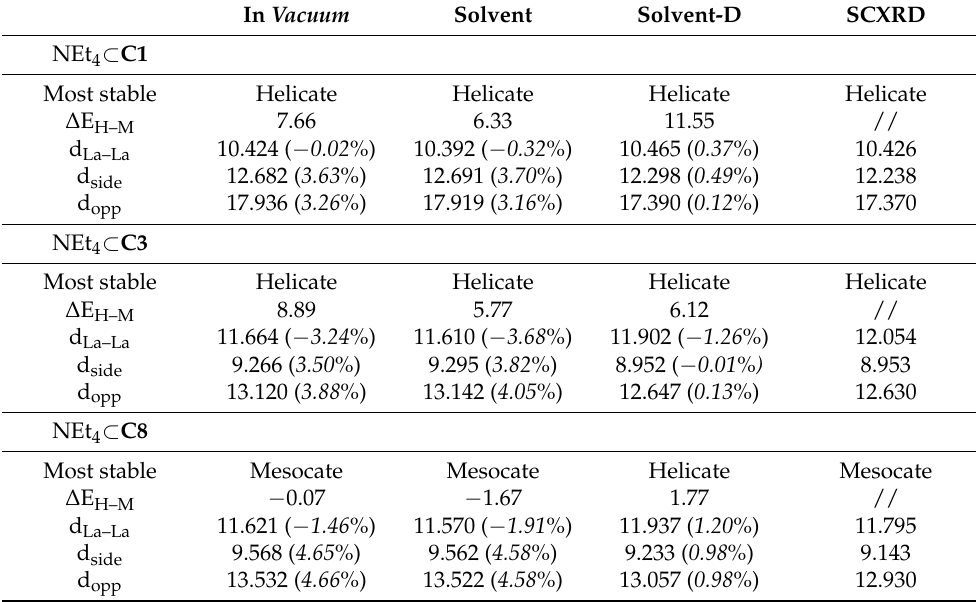
Table 1. Experimental and calculated values for NEt 4 ⊂ C cages ( C1 , C3 , C8 ) with the NEt 4+ guest. The C1 and C3 cages’ experimental and calculated values are reported for helicate isomer [23,24], while for the C8 the mesocate isomer values are reported [24]. ∆ E H–M is the difference between helicate and mesocate in kcal/mol. A positive value means a more stable helicate with respect to the mesocate, while a negative value denotes the contrary. All distances are in Å. In parenthesis in italics the percentage error between the experimental and calculated distance values. In Vacuum Solvent Solvent-D SCXRD NEt 4 ⊂